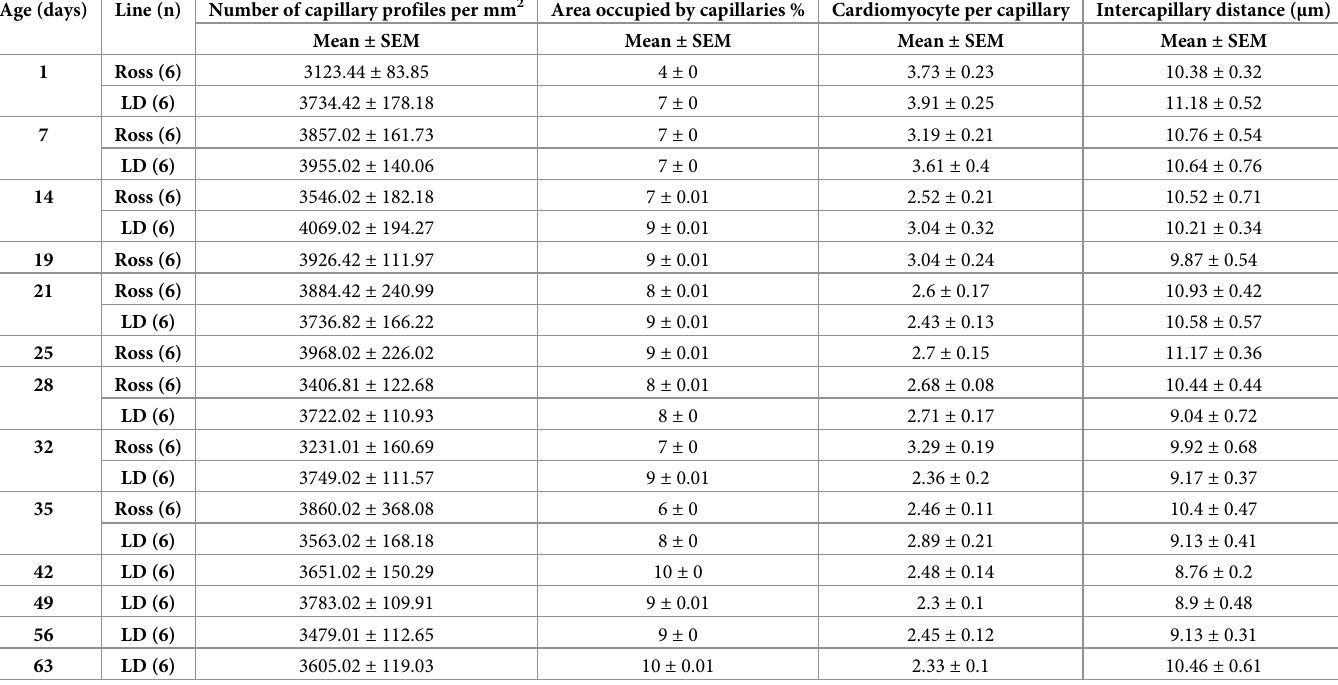
Table 3. Ventricular capillary and cardiomyocyte measurements over time of LD and Ross chicken